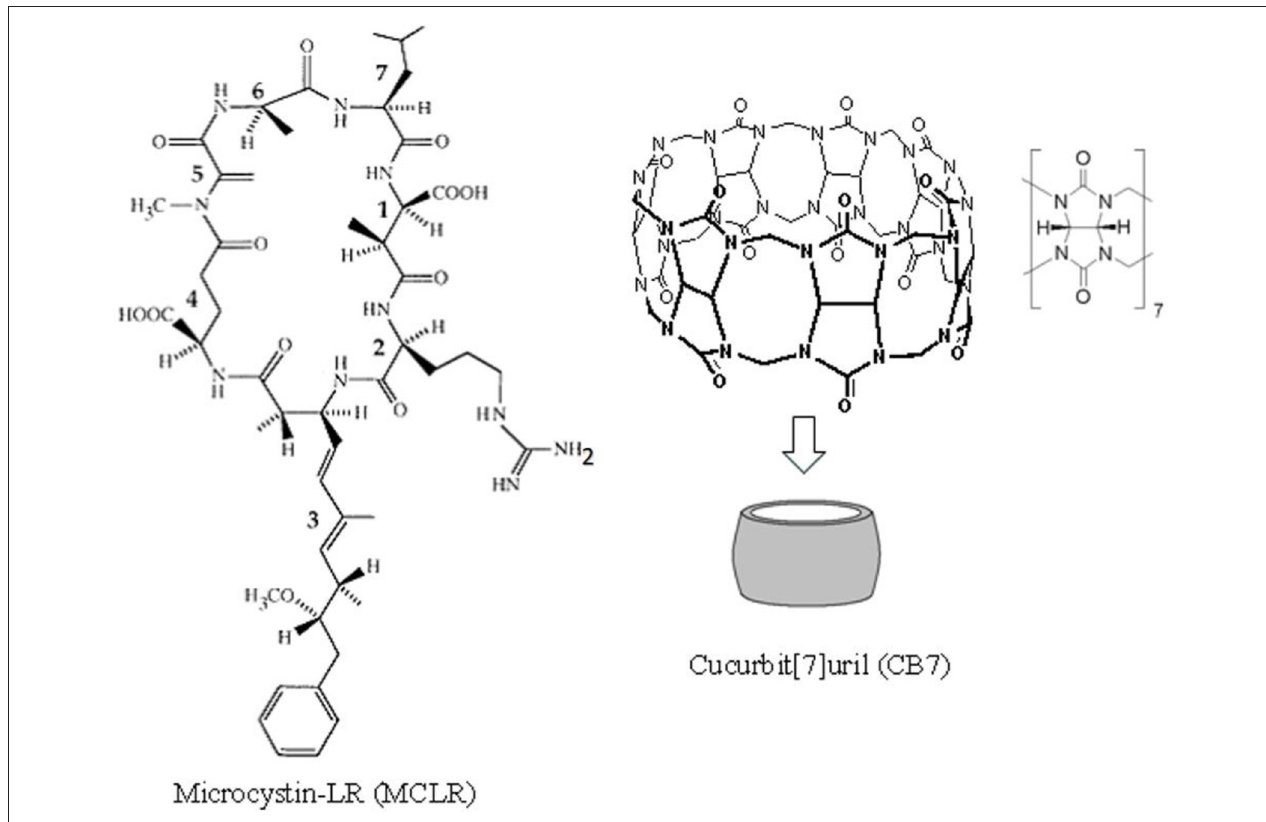
FIGURE 1 | The chemical structures for cucurbit[7]uril (CB7) and microcystin-LR (MC-LR). MC-LR is a cyclic heptapeptide toxin comprising (1) methylaspartic acid; (2) L -arginine; (3) 3-amino-9-methoxy-2,6,8-trimethyl-10-phenyldeca-4,6-dienoic acid; (4) D -glutamic acid; (5) N-methyldehydro-alanine; (6) D -alanine; and (7) L